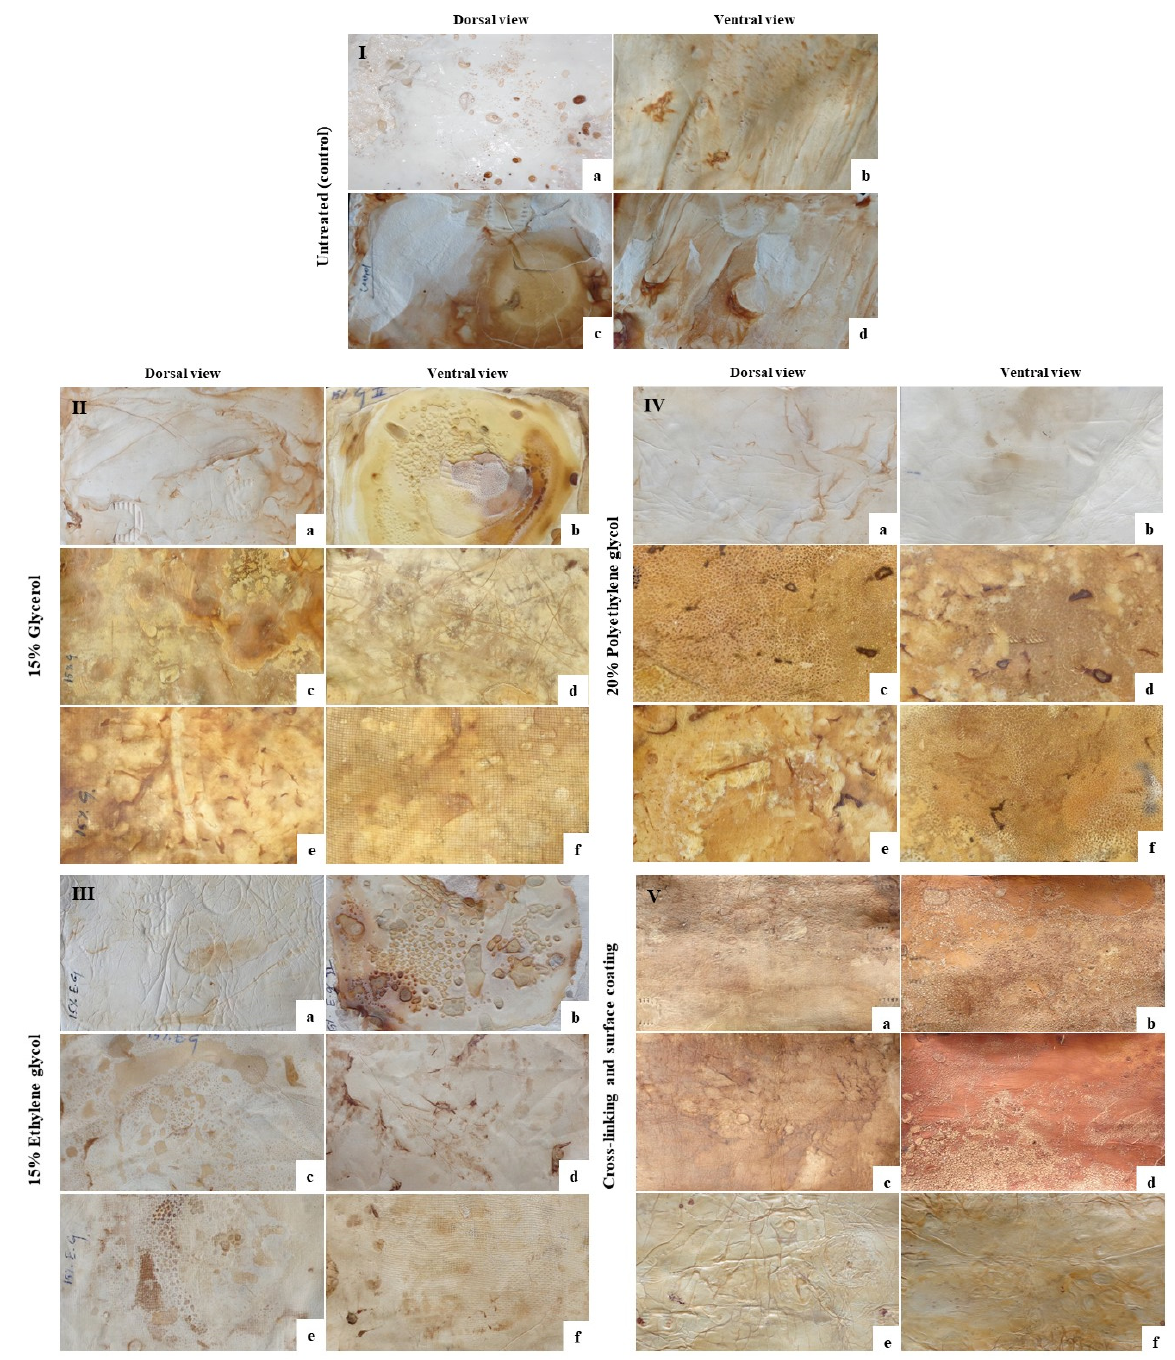
Figure 3. Surface view of the plasticized and hotpressed MBL obtained from F. fraxinea . ( I ) Untreated control ( a , b ) fresh mycelium, ( c, d ) hotpressed; ( II ) 15% glycerol-treated ( a, b ) without hotpress, ( c, d ) hotpressed, ( e, f ) cheesecloth overlaid with hotpress; ( III ) 15% ethylene-glycol-treated ( a , b ) without hotpress ( c, d ) hotpressed, ( e, f ) cheesecloth overlaid with hotpress; ( IV ) 20%-PEG-treated ( a , b ) without hotpress; ( c, d ) hotpressed; ( e, f ) cheesecloth overlaid with hotpress; ( V ) crosslinked and surface-coated ( a , b ) 15% EG + 5% tannic acid, ( c, d ) 15% EG + 10% tannic acid, ( g, h ) 15% EG + 20% coated with corn zein.